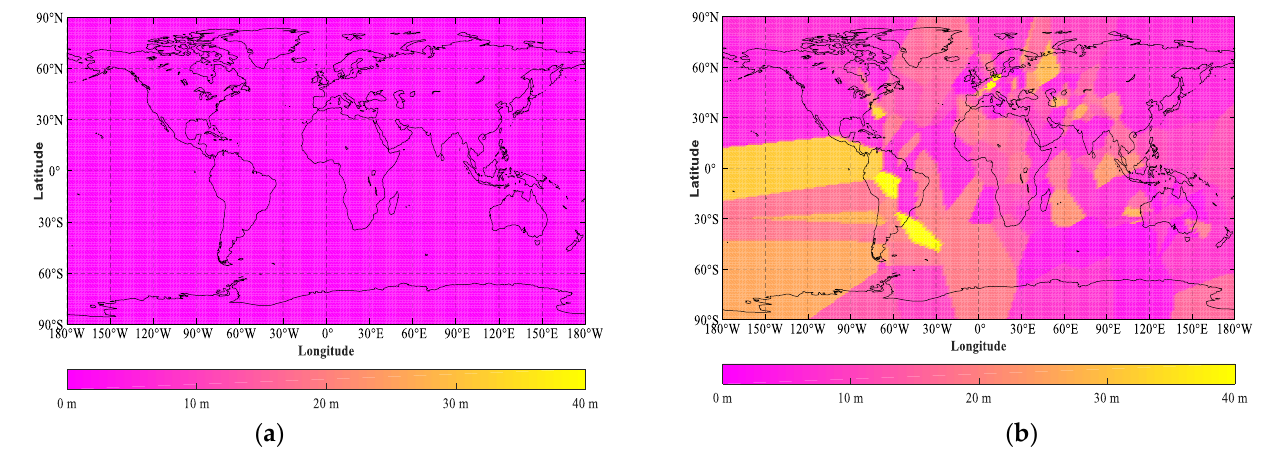
Figure 3. Global threshold distribution of CODM based on (a) GPS and (b) BDS observation under case1 and case2. Table 1. statistics of CODM test statistics and RMSE (m).